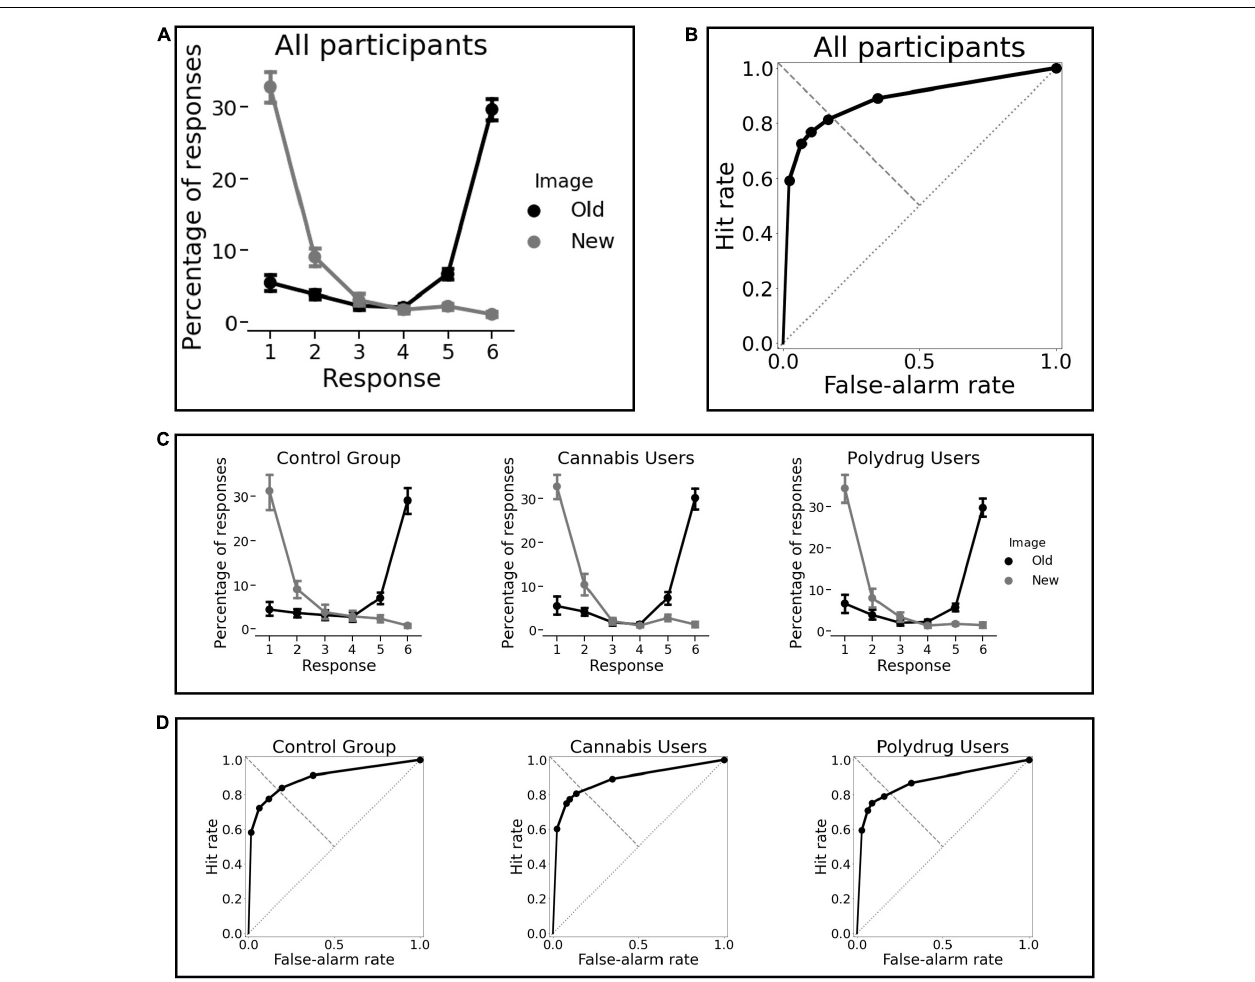
FIGURE 3 | Behavioral results. (A) Percentage of responses “old” and “new” as a function of confidence for all participants As X -axis corresponds to participants’ rating (1 = new, confident; 6 = old, confident) the highest probabilities for responses Old and New were 6 and 1. (B) The average receiver operating characteristic of all subjects. (C) Percentage of responses “old” and “new” as a function of confidence for each group separately. (D) The average receiver operating characteristic for each group separately. There were no significant differences between groups for any memory performance indicator and we can observe obvious similarities in memory performance across